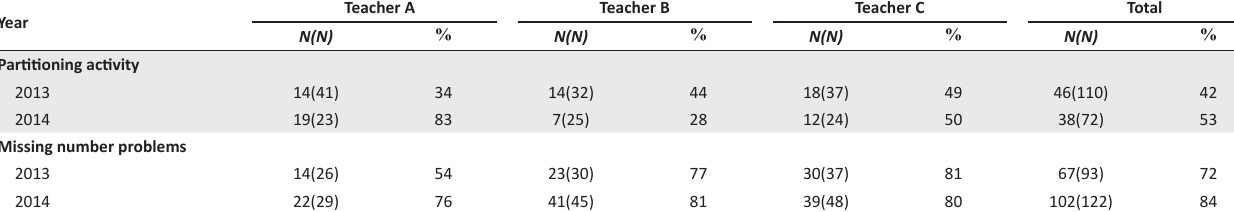
TABLE 3: Summary of segments coded as simultaneity and connections within examples, in 2013 and 2014.